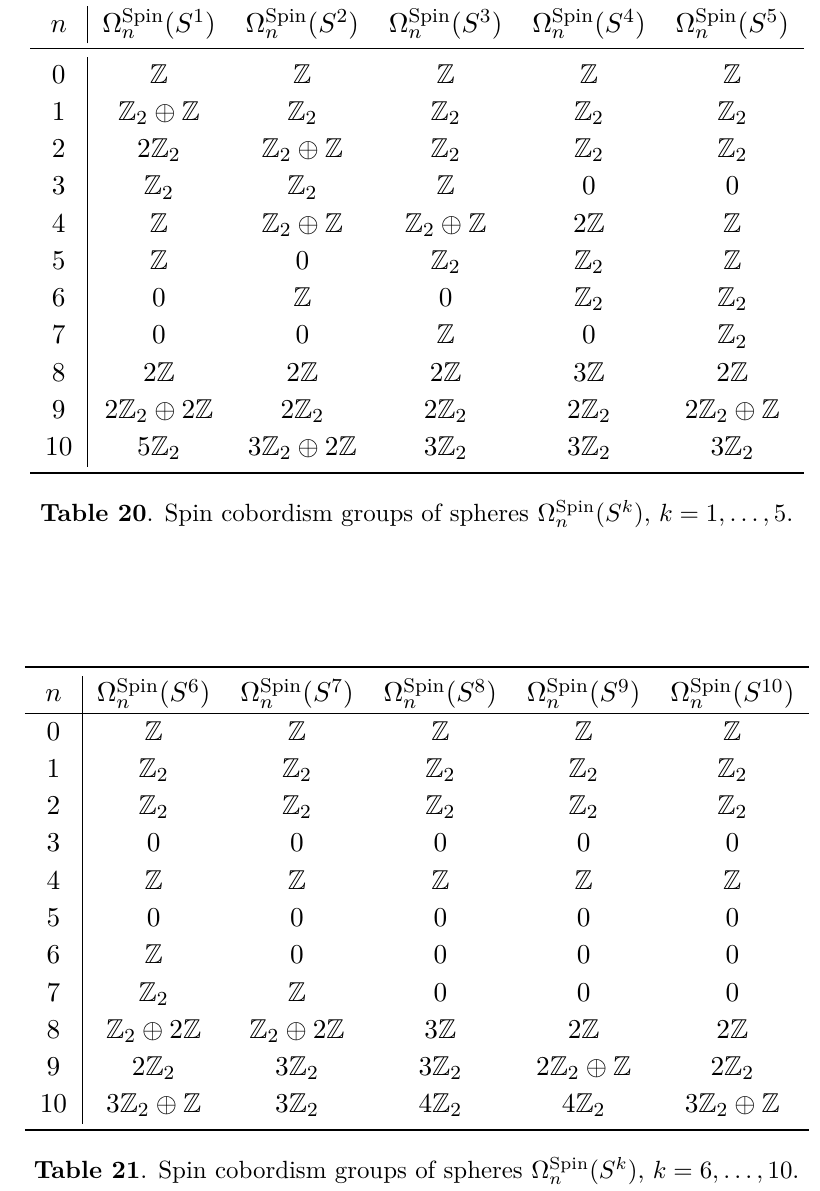
Table 21 . Spin cobordism groups of spheres Ω Spin